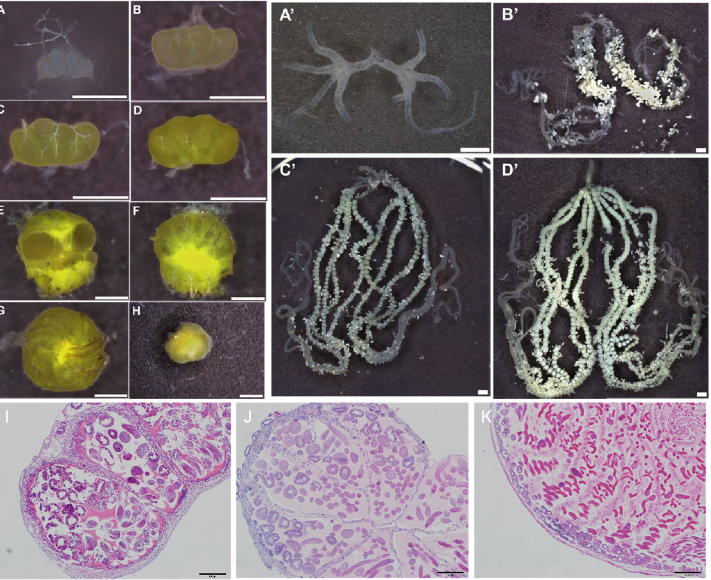
Figure 1. Development of H. armigera testis and ovary. ( A – H ) The testes of L4, L5, L6, pre-pupa, pupa, and newly emerged (0-day-old) male adults, respectively. ( A’ – D’ ) The ovaries of pupa, newly emerged (0-day-old) female adults, 1-day-old female adults, and 2-day-old female adults, respectively. Bar = 1 mm. ( I – K ) The testis tissue of larvae, late pupal stage, and newly emerged adults, respectively, by H&E staining. Bar = 100 µ m. ( A – H , A’ – D’ ) Photos taken by a hyperdepth 3D microscope (Smartzoom5 1810070S, Zeiss). Photos of ovaries were stitched by